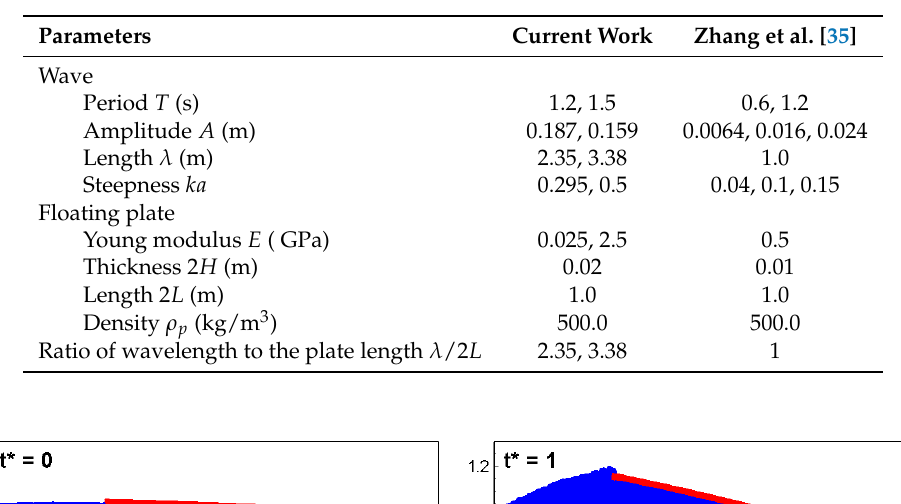
Table 1. Summary of the parameters used in the current study in comparison with those investigated in Zhang et al. [35].